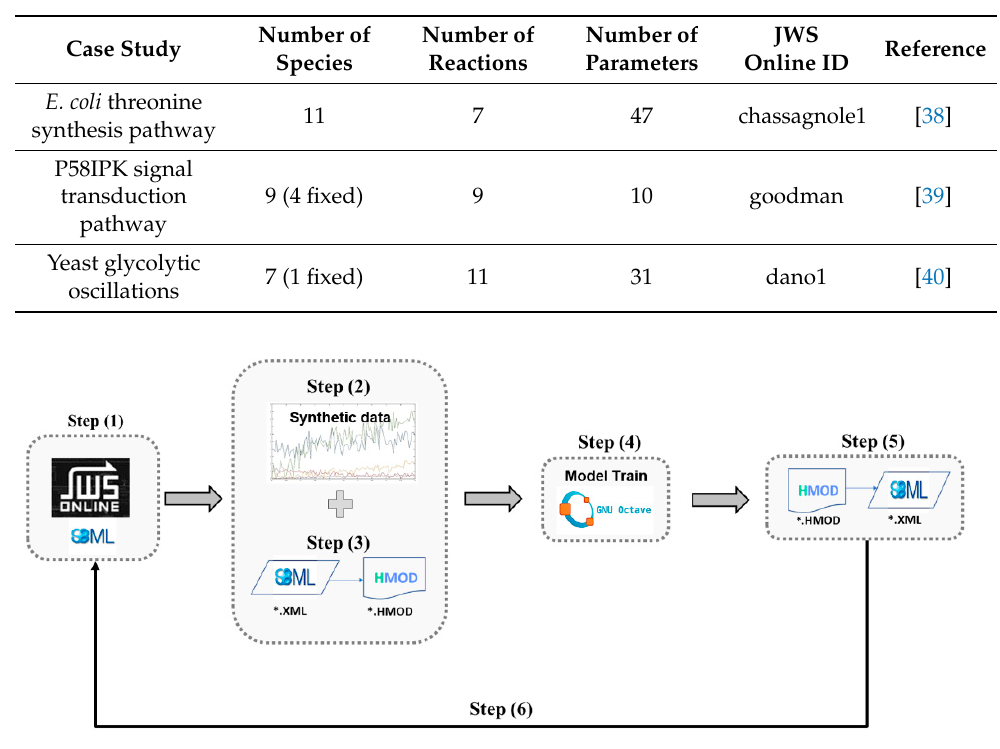
Figure 1. Schematic workflow for redesigning existing SBML models stored in databases into hybrid mechanistic/neural network models. Step 1: An SBML biologic model is extracted from a model database. Step 2: A synthetic time series dataset is generated to train the hybrid model. Step 3: A feedforward neural network (FFNN) is inserted in the mechanistic kinetic model and converted to the HMOD format using the SBML2HYB tool. Step 4: The hybrid mechanistic/FFNN model encoded in the HMOD format is trained by applying the deep learning approach (Section 2.1) and the synthetic dataset. Step 5: The trained hybrid model in the HMOD format is reconverted to SBML using the SBML2HYB tool. Step 6: The final trained hybrid model in the SBML format is uploaded in the model database and simulated comparatively to the original nonhybrid Table 1. Summary of the three SBML models that were redesigned to hybrid mechanistic/neural network models in the present study.